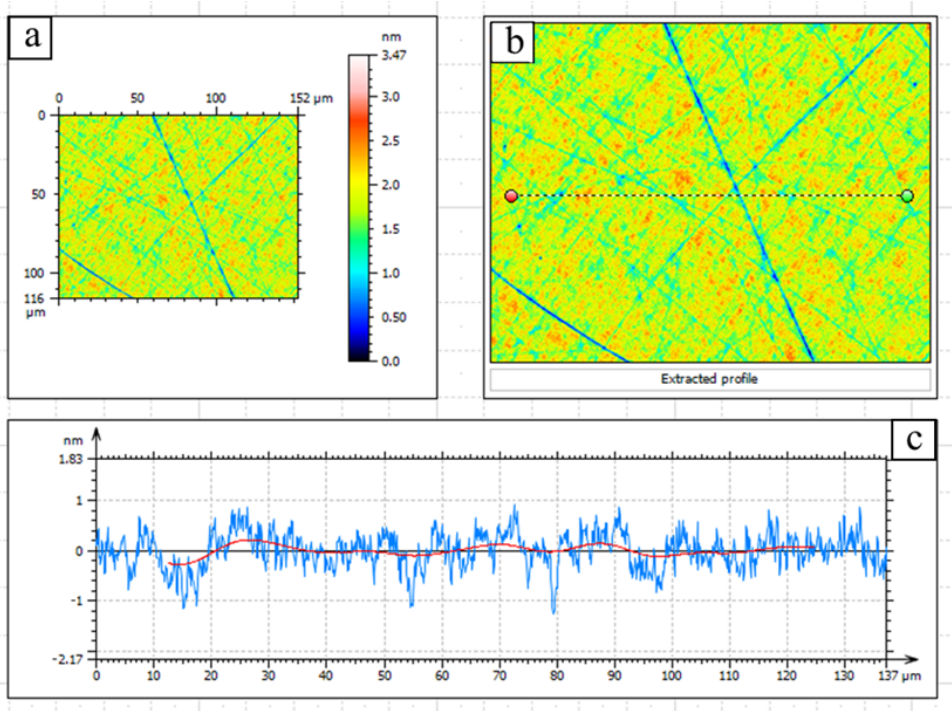
Figure 1. Surface topography and roughness profile of sample No. 1. ( a ) . Surface topography of sample, ( b ) Surface topography of sample with a dashed line, ( с ) roughness profile of the sample along the dashed line.